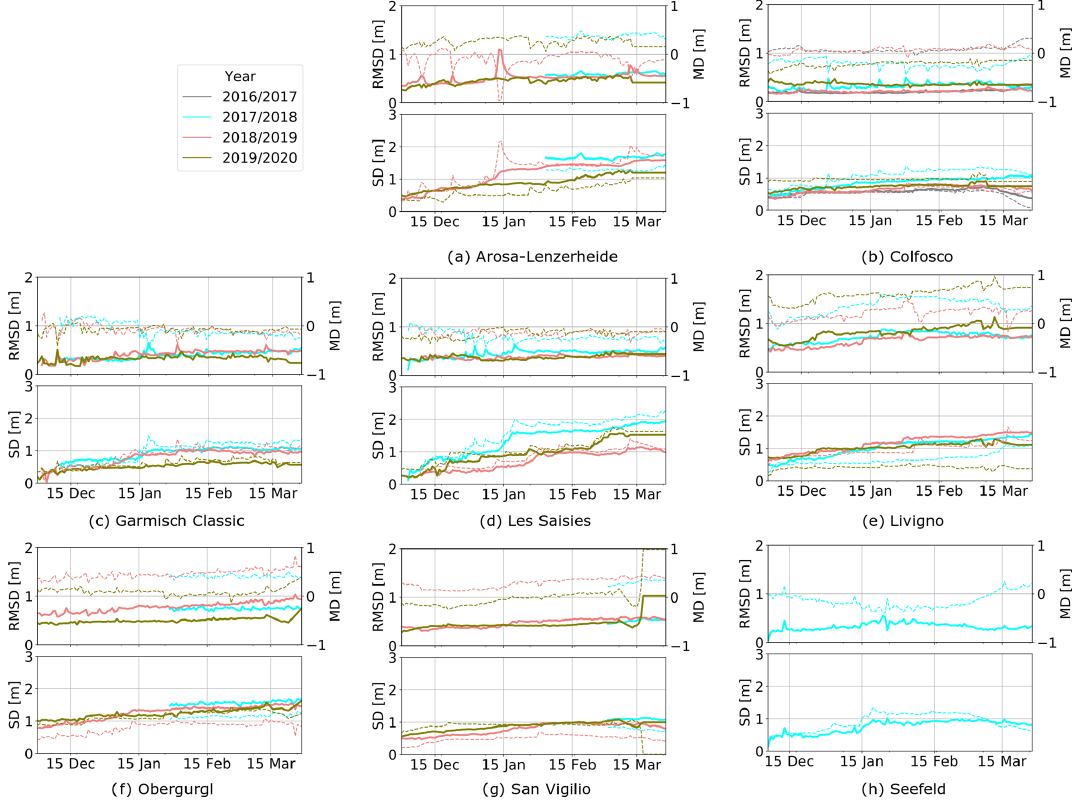
Figure 5. Root mean square deviation (RMSD) (upper subplots: solid line, left axis) and mean deviation (MD) (upper subplots: dashed line, right axis) averaged over space between GNSS-measured snow depth (SD) (lower subplots: solid line, left axis) and simulated SD (lower subplots: dashed line, right axis) over time for the ski resorts. Within the period 2016–2020 we considered all valid GNSS-measured snow depth data which were